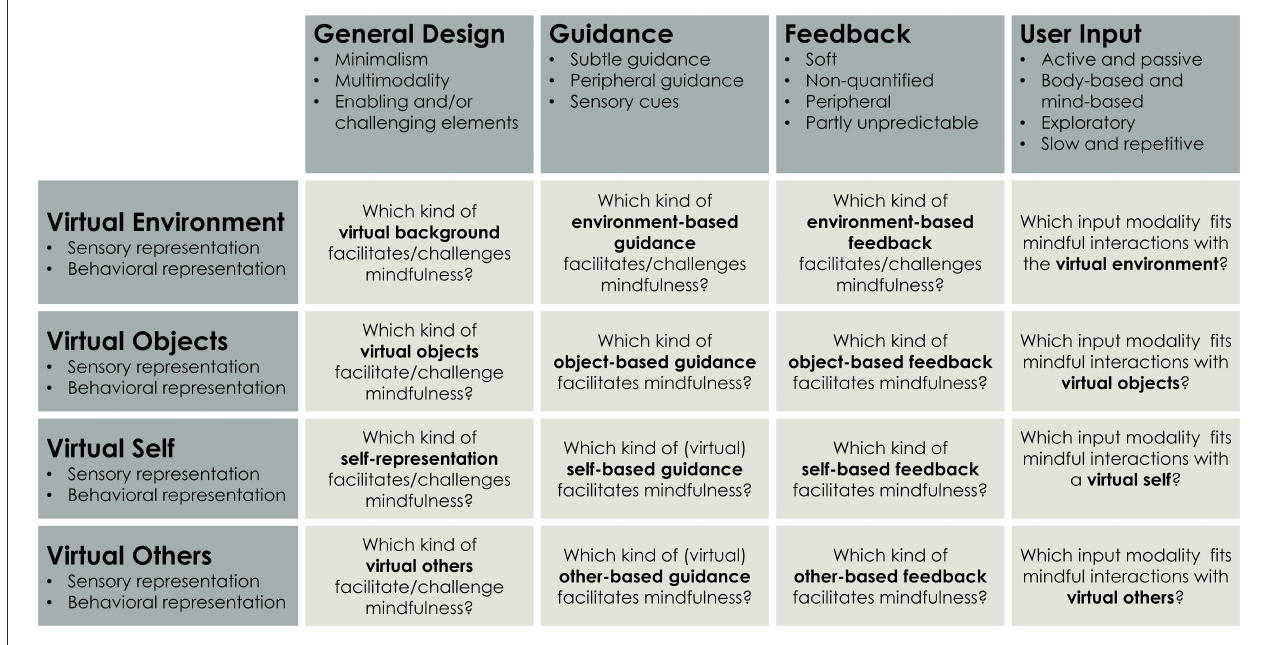
FIGURE 6 | Overview of the combinations of design guidelines for digital mindfulness support and the XR